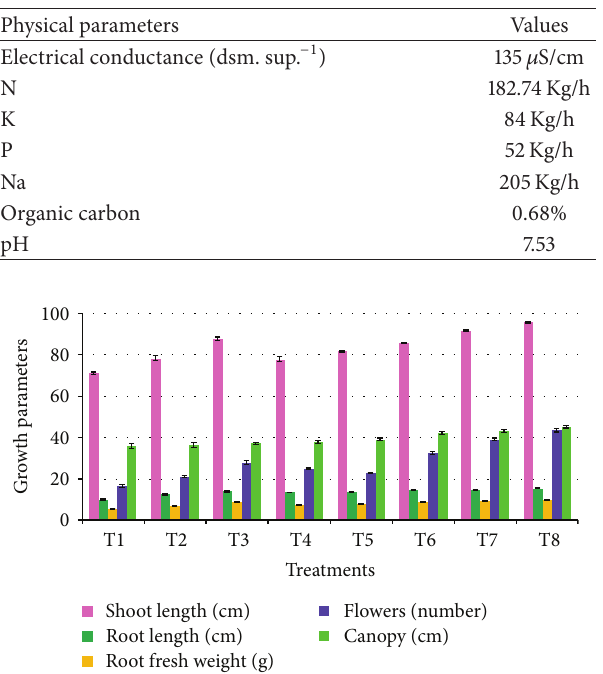
Table 1: Physical parameters of the soil.